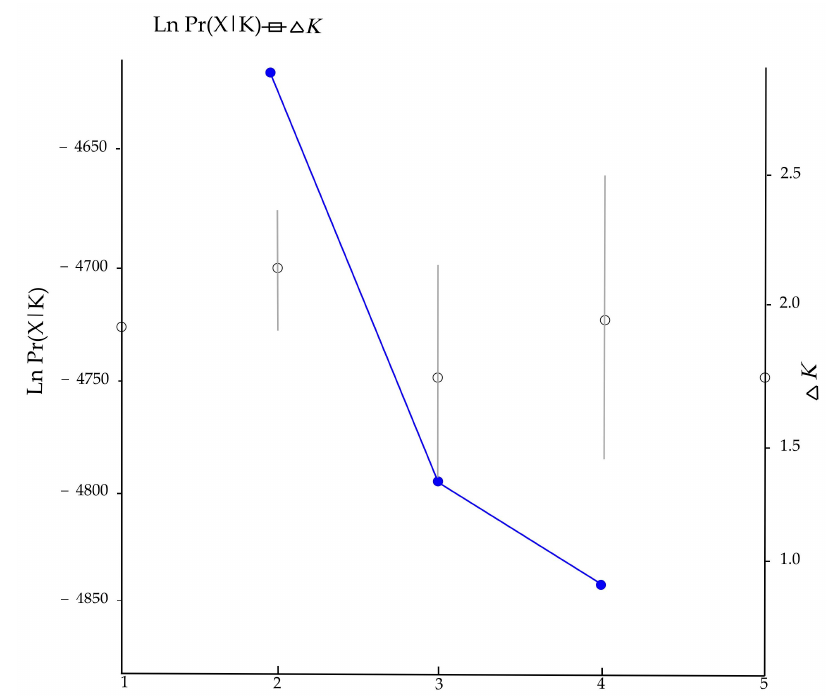
Figure 3. Changing trends of Ln Pr(X|K) and Delta K from STRUCTURE clustering results.